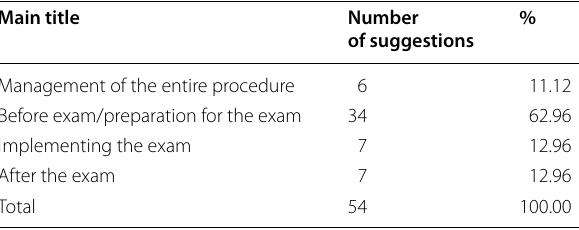
Table 4 Distribution of suggestions by main title